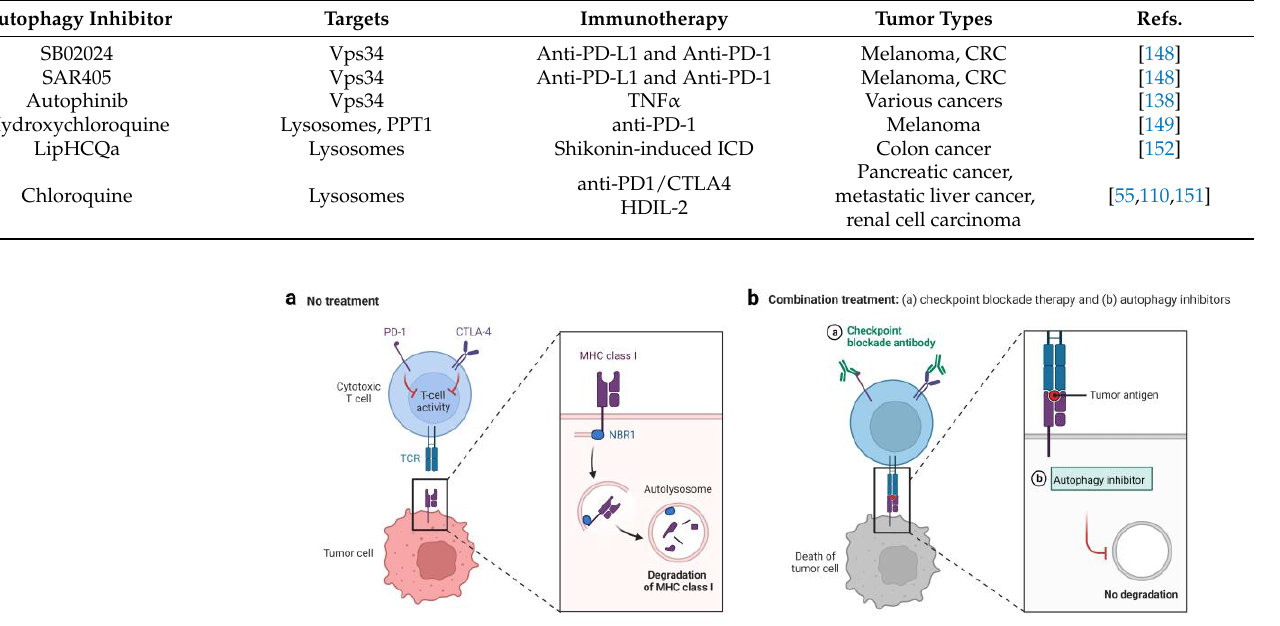
Figure 3. Autophagy blockage sensitizes cancer cells to immunotherapy. ( a ) In tumor cells, surface MHC-I is degraded by the autophagy-lysosome traffic, facilitating malignant cells to evade im- munologic surveillance. ( b ) Blockage of autophagosome or lysosome intercepts MHC-I degradation, enhancing efficacy of checkpoint blockage inhibitors. Table 1. Autophagy inhibitors enhance the efficacy of immunotherapy.